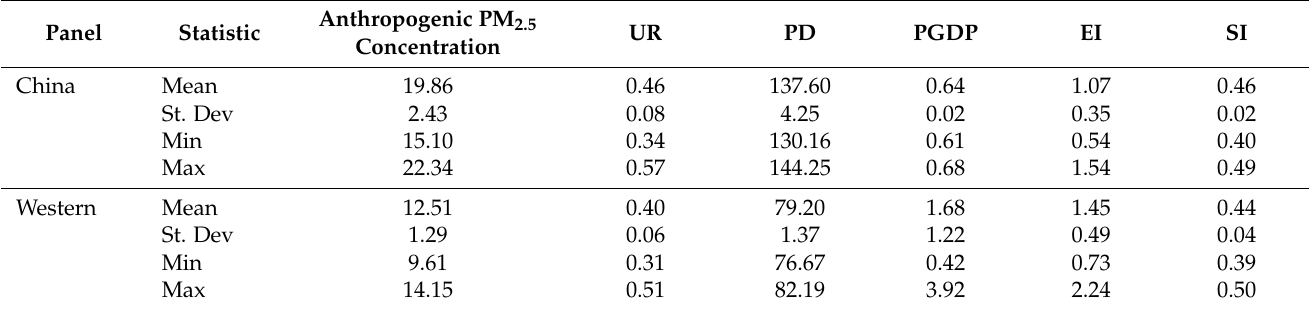
Table 2. Summary statistics of the panel data.